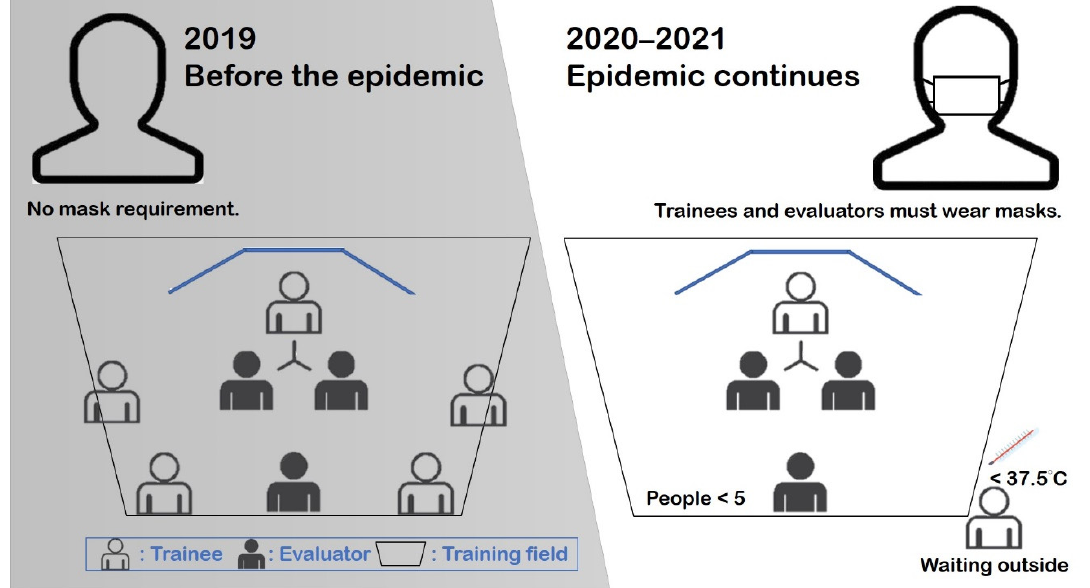
Figure 9. Adjustment due to COVID-19 prevention. Table 4. T Test analysis of trainees’ post-test scores before and during the outbreak. Dimensions